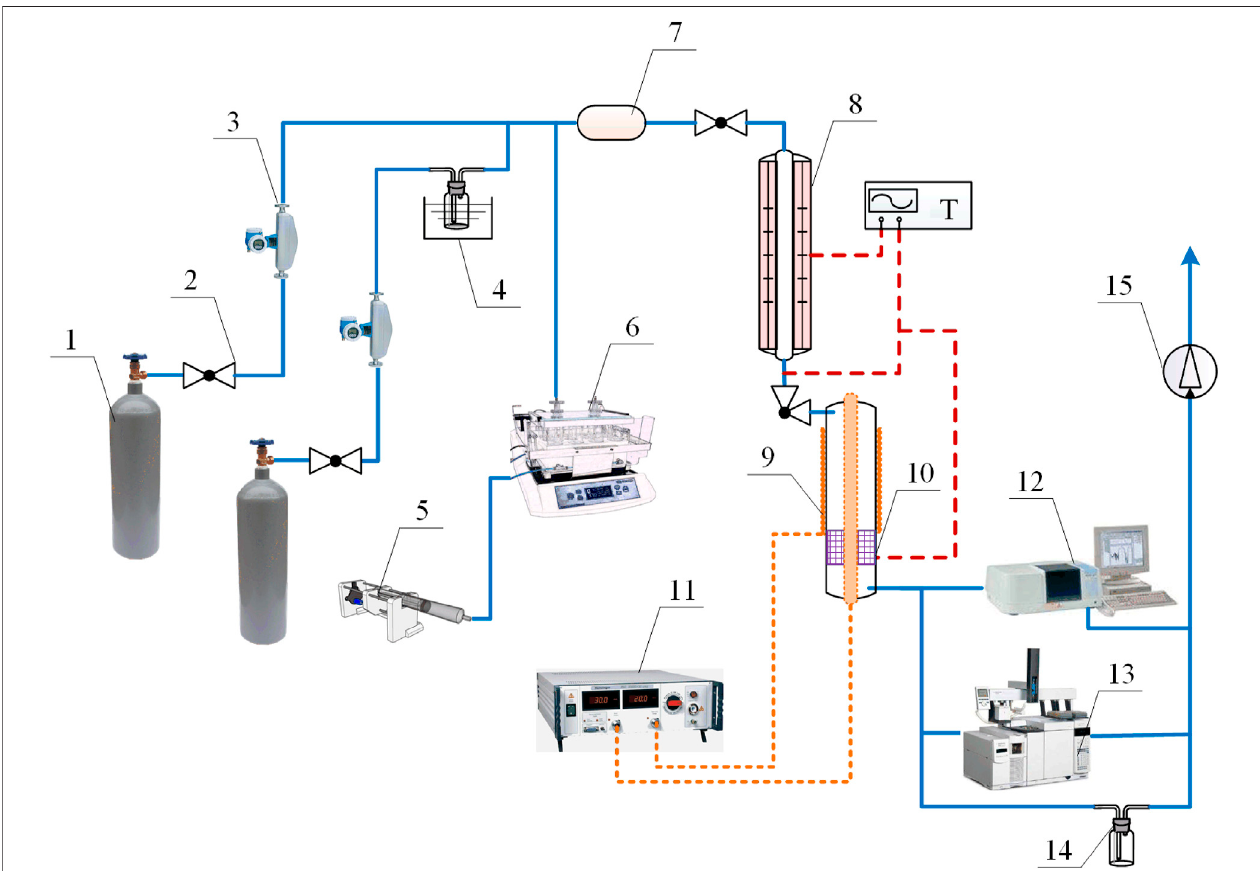
FIGURE1| ZIFscouplingNTPcatalyticVOCsexperimentaldevicediagram:(1)Standardgascylinder;(2)On-offvalve;(3)Mass fl owmeter;(4)waterevaporator;(5) VOCs injection pump; (6) VOCs evaporator; (7) Gas mixing cylinder; (8) Temperature control section; (9) NTP catalytic section (10) ZIFs catalysts (11) Plasma high- frequency power supply (12) VOCs analyzer (13) composite gas analyzer (14) Gas scrubber (15) induced draft fan.